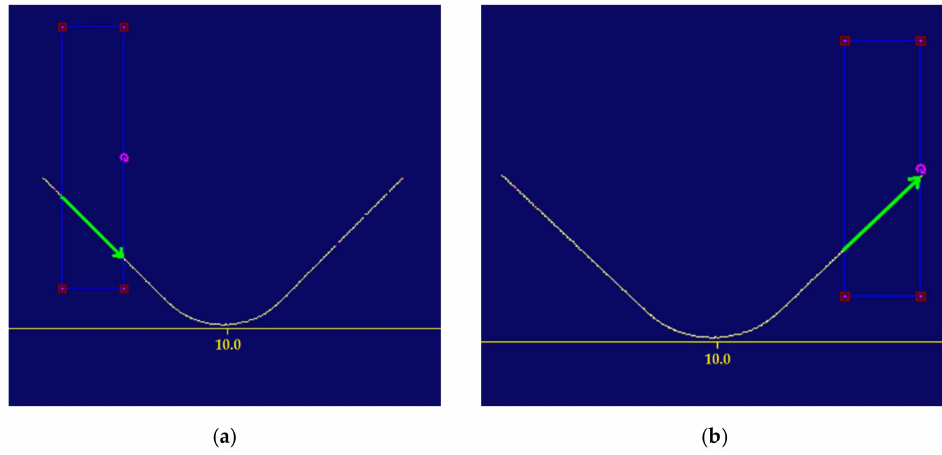
Figure 13. Straight line approximation of the arms on the left ( a ) and the right-hand ( b )